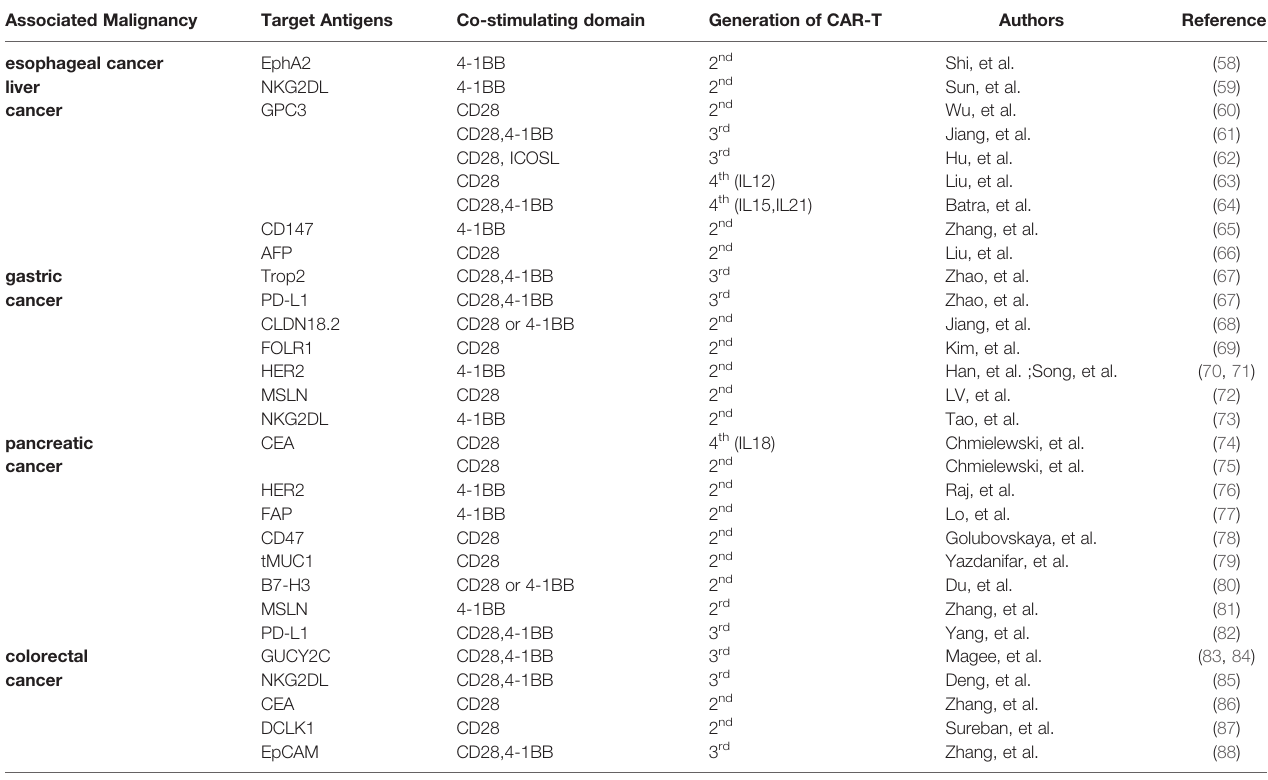
TABLE 2 | Some TAAs targeted by CAR-T cells (taking gastrointestinal tumors as an example). Associated